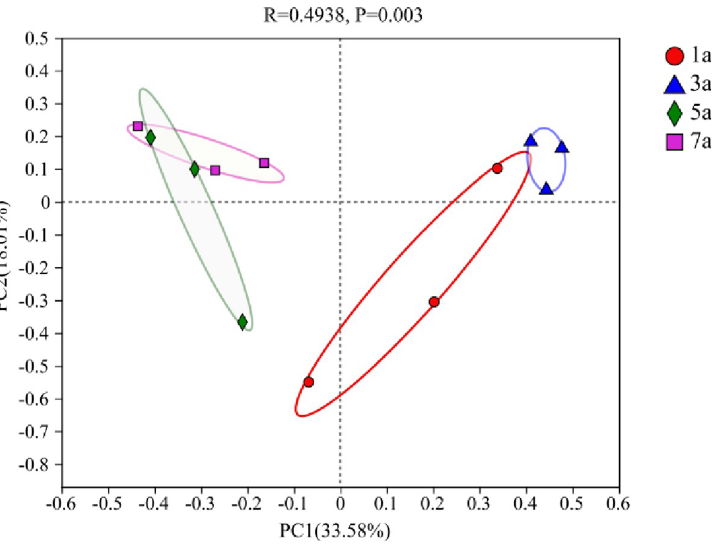
Fig 4. PCoA analysis of fungal